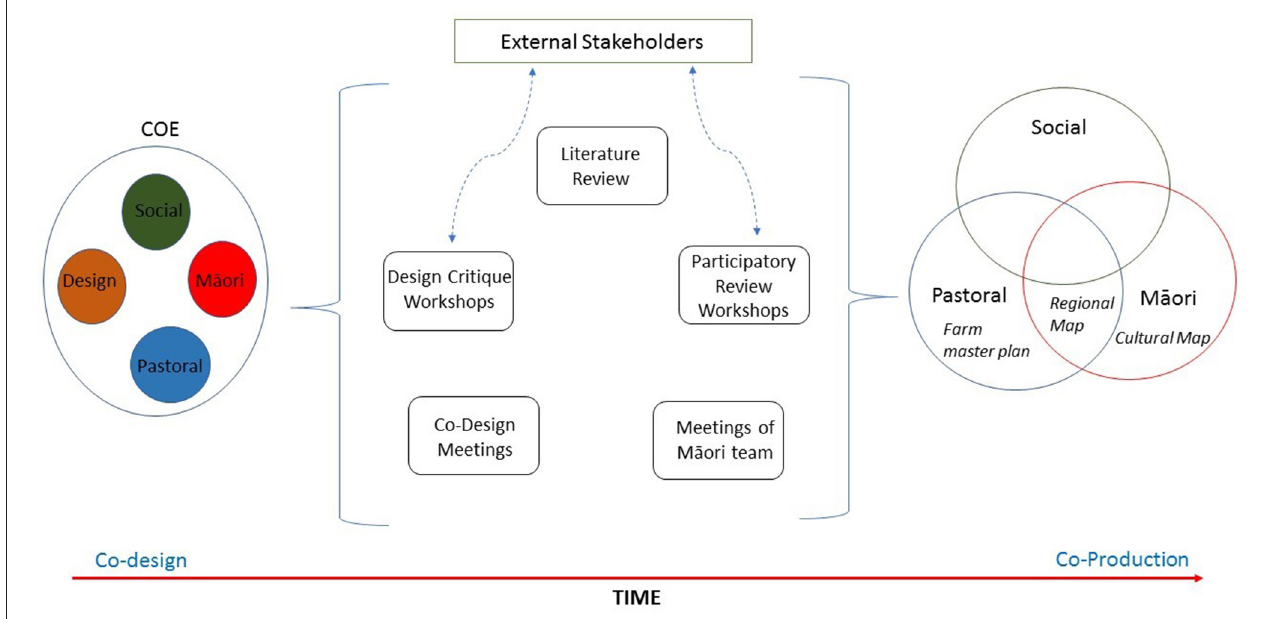
FIGURE 1 | Diagram showing various parts of knowledge co-production at the